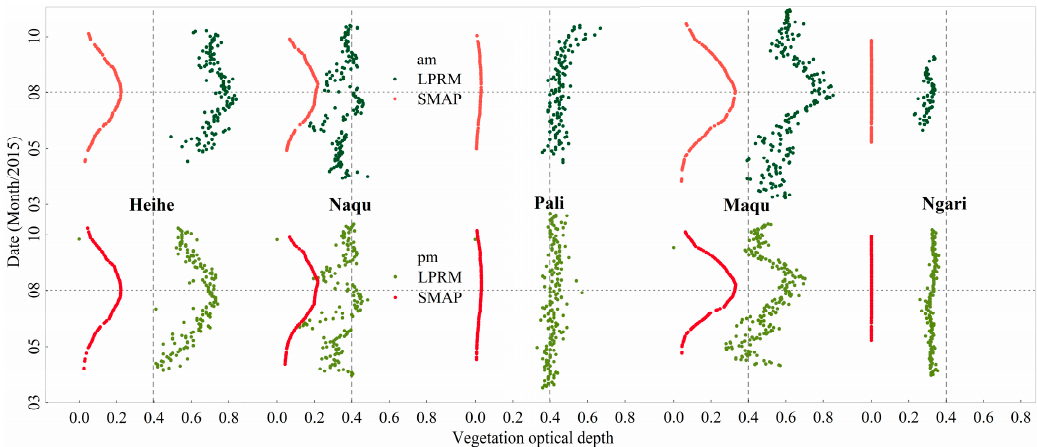
Figure 12. Time series that compare the τ estimates from two SM models over the five in situ networks for 2015.